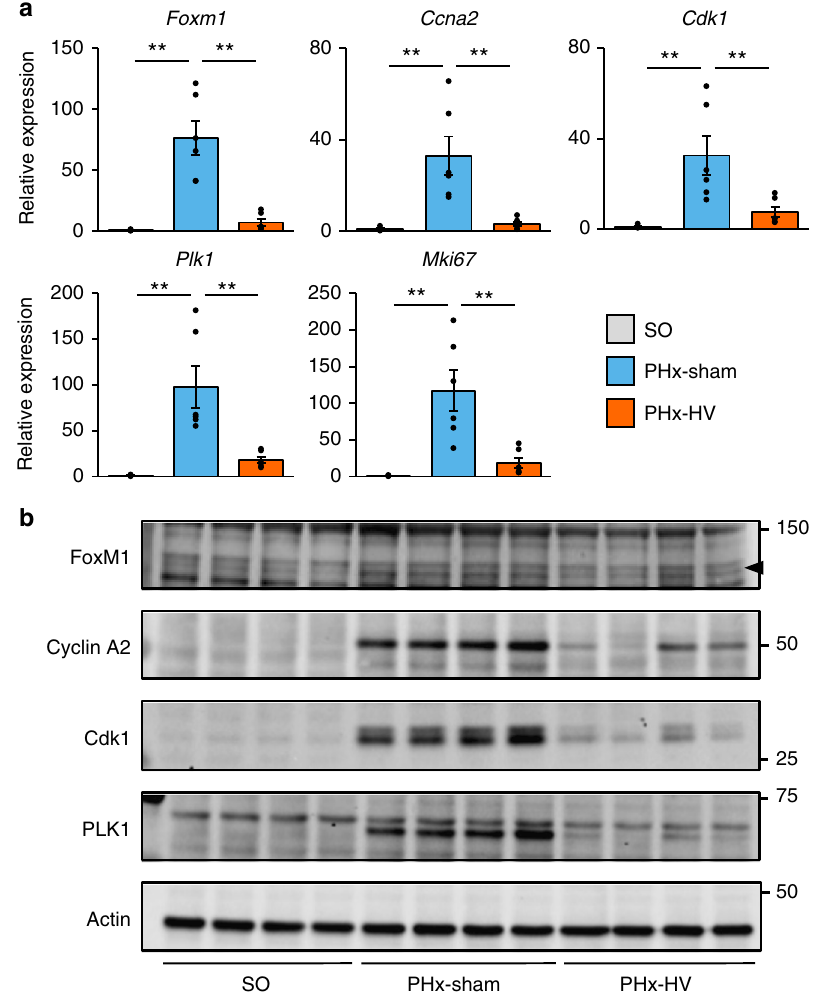
Fig. 2 Vagal signals are involved in activation of hepatic FoxM1 after PHx. a Relative expressions of Foxm1 , its target genes. and MKi67 in the liver 2 days after SO ( n = 4), PHx-sham ( n = 6), and PHx-HV ( n = 6). b Images of liver extract immunoblottings with anti-FoxM1, Cyclin A2, Cdk1, PLK1, and actin in SO, PHx-sham, and PHx-HV mice on postoperative day 2. Arrowhead indicates bands for FoxM1. Data are presented as means ± SEM. * P < 0.01 assessed by one-way ANOVA followed by Bonferroni ’ s post hoc test ( a ). n.s., not signi fi